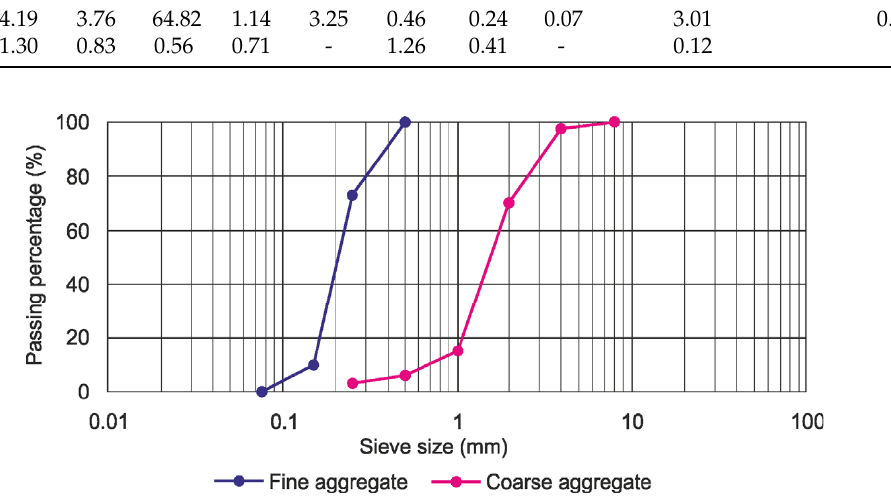
Figure 1. Particle size distribution of aggregates. Table 1. Physical properties and costs of cement and CSF.